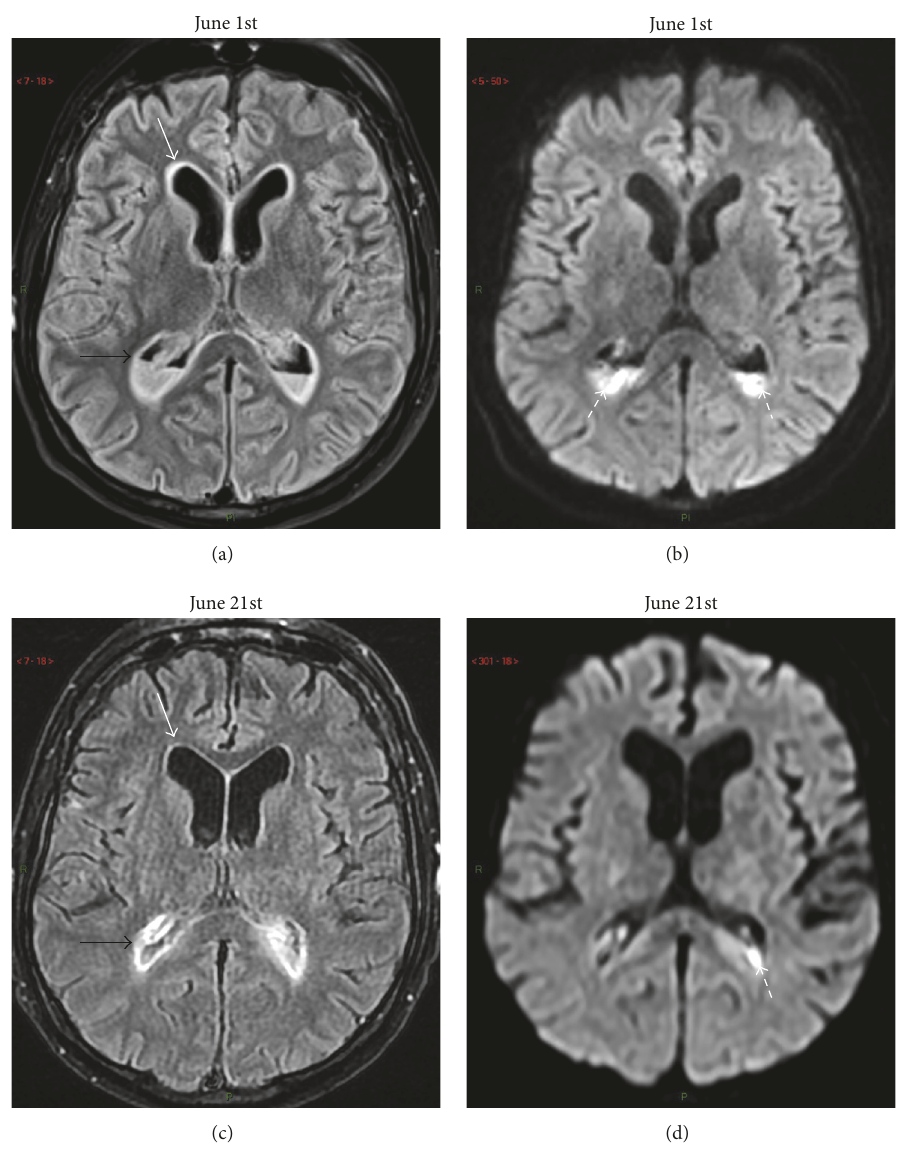
Figure 1: (a-b) Admission brain MRI; (c-d) follow-up brain MRI three weeks later. (a) Contrast-enhanced (CE) axial transverse fluid- attenuated inversion-recovery (FLAIR) view at admission showing diffuse abnormal enhancement of ependyma (white arrow) and bilateral fluid-fluid level at trigonal areas of lateral ventricles (black arrow). (b) Admission diffusion-weighted (DW) axial transverse view at admission at similar slice location as in (a) showing high signal intensity within declive sediment of the fluid-fluid level featuring pus with free water diffusivity restriction (dotted arrows). (c) CE FLAIR view in similar slice location as in (a) three weeks later showing complete subsidence of ependymal contrast-enhancement (white arrow) and disappearance of the fluid-fluid levels (black arrow). Only persistent enhanced brightness of ependymal lining was seen. (d) DW image in similar slice location as in (b) showing only minimal purulent residue within left ventricular trigone (dotted